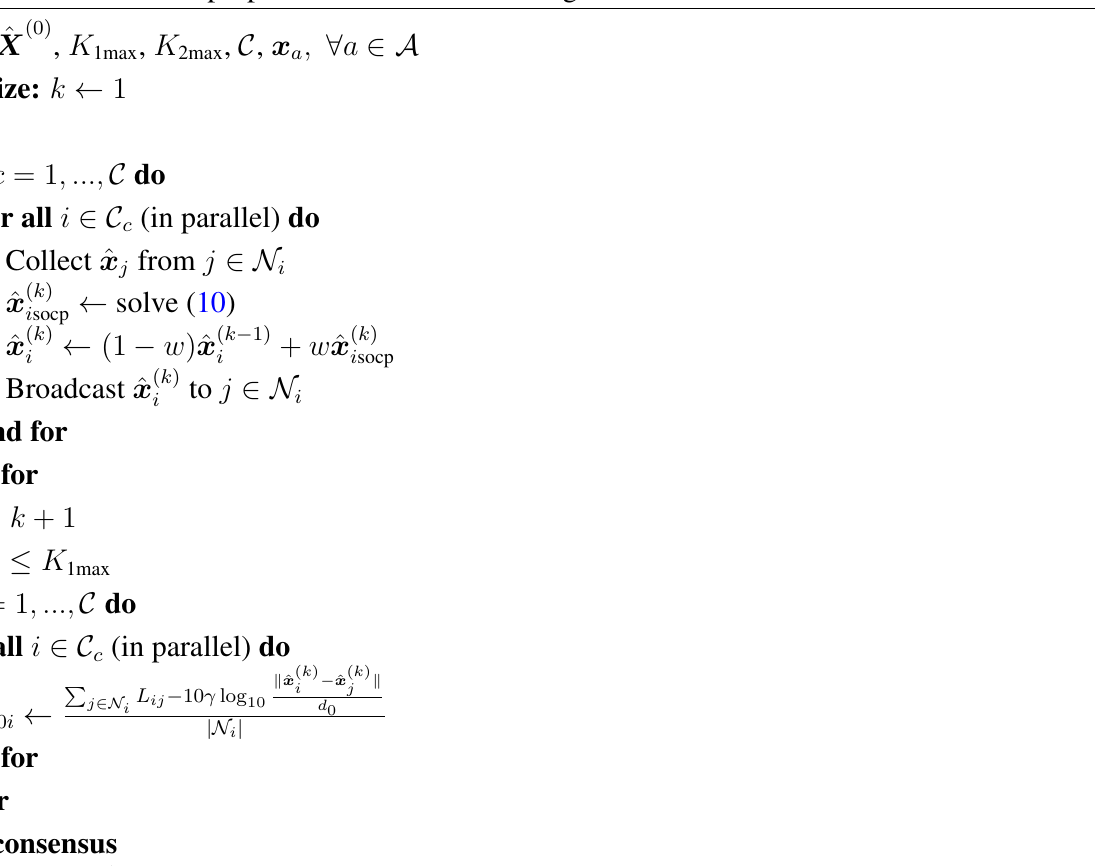
Algorithm 2 “SOCP2”: the proposed distributed SOCP algorithm for unknown P